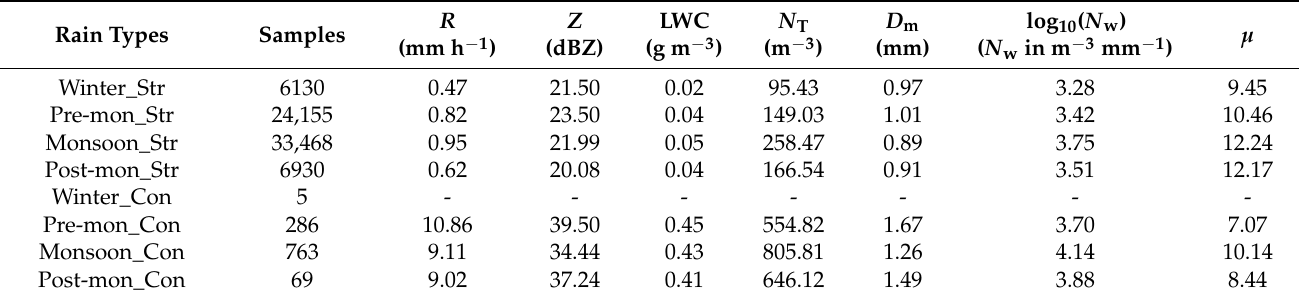
The average microphysical parameters of stratiform rain and convective rain in different